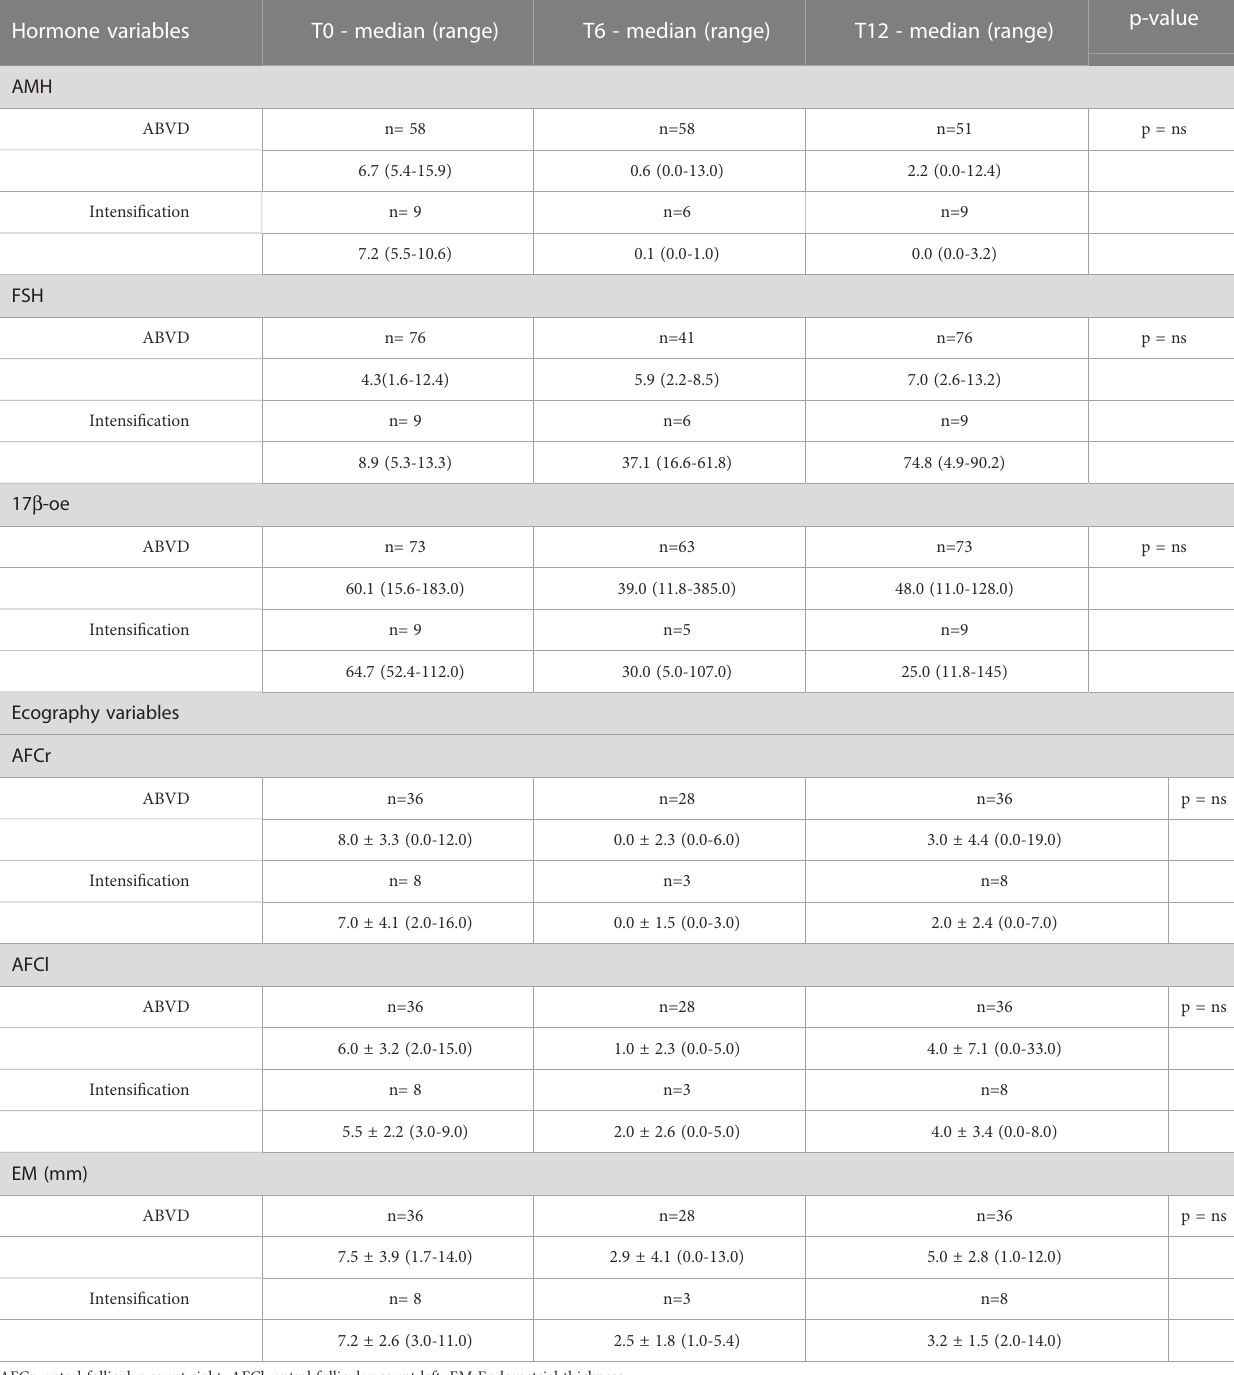
Hormone variables T0 - median